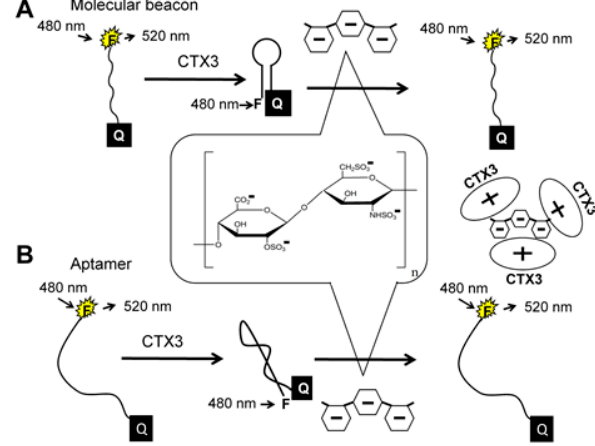
Figure 1. Turn-on fluorescence detection of heparin based on competitive binding ( A ) between heparin and molecular beacon (MB) to CTX3 or ( B ) between heparin and aptamer to CTX3.